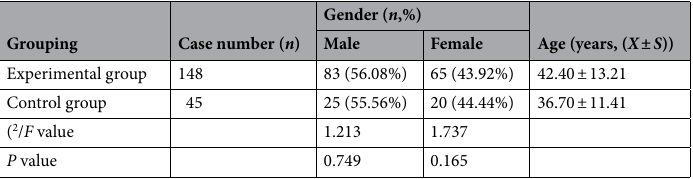
Table 1. Comparison of general data.